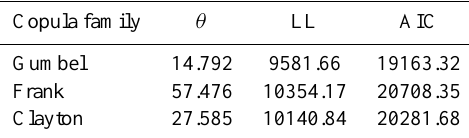
Table 7. Goodness of fit results for copula ( Q max ,V )